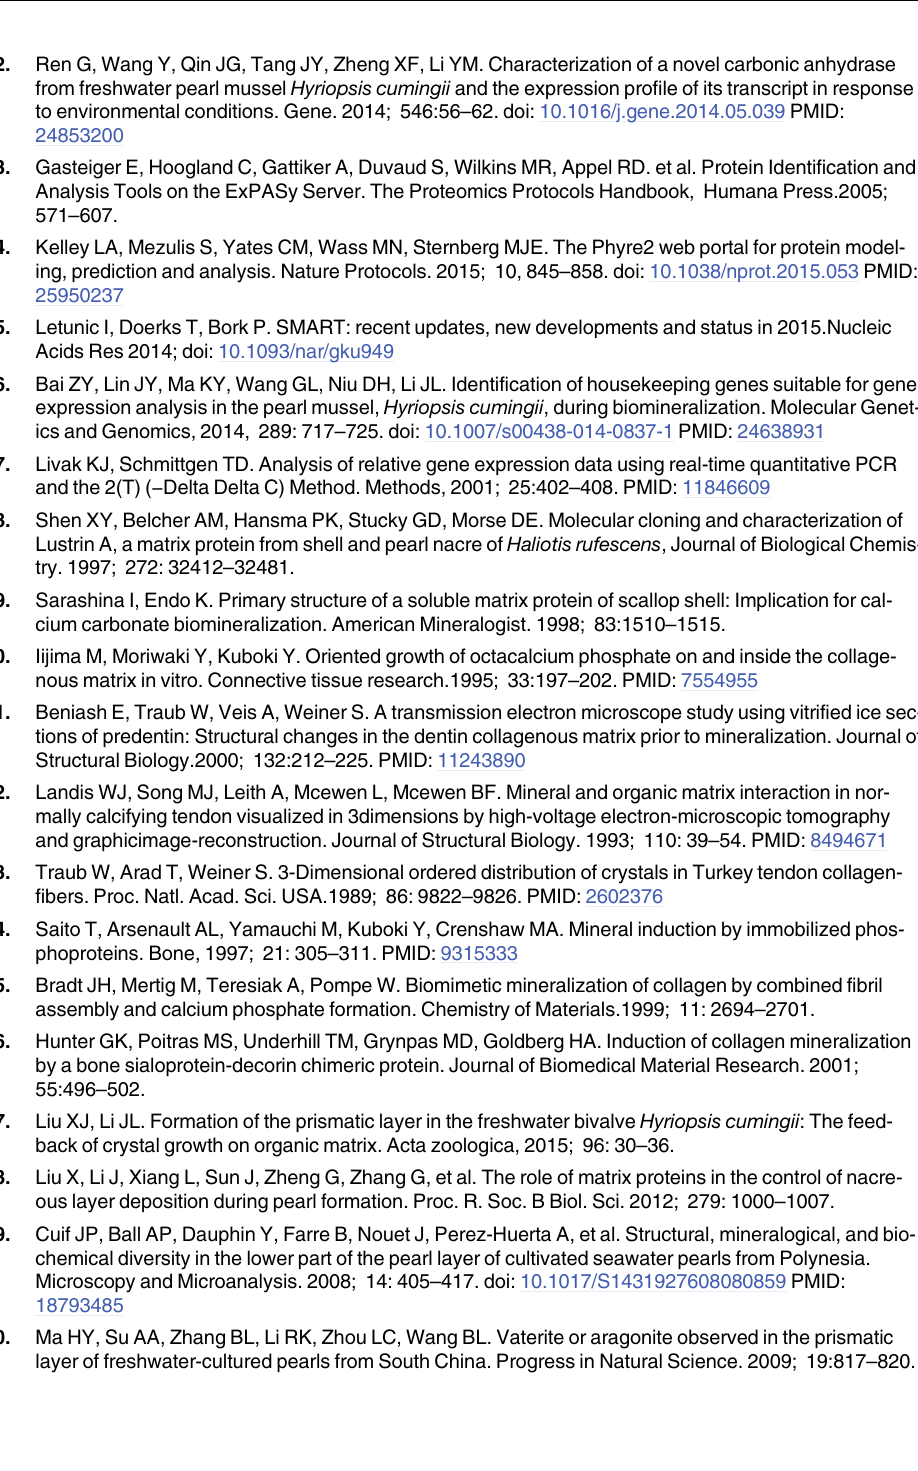
PLOS ONE | DOI:10.1371/journal.pone.0135123 August 11,